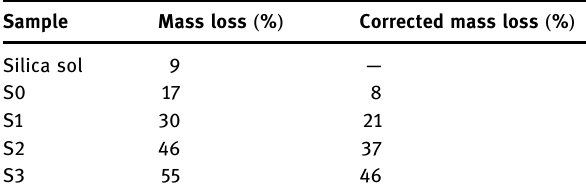
Table 1: Mass loss data from TG curves Sample